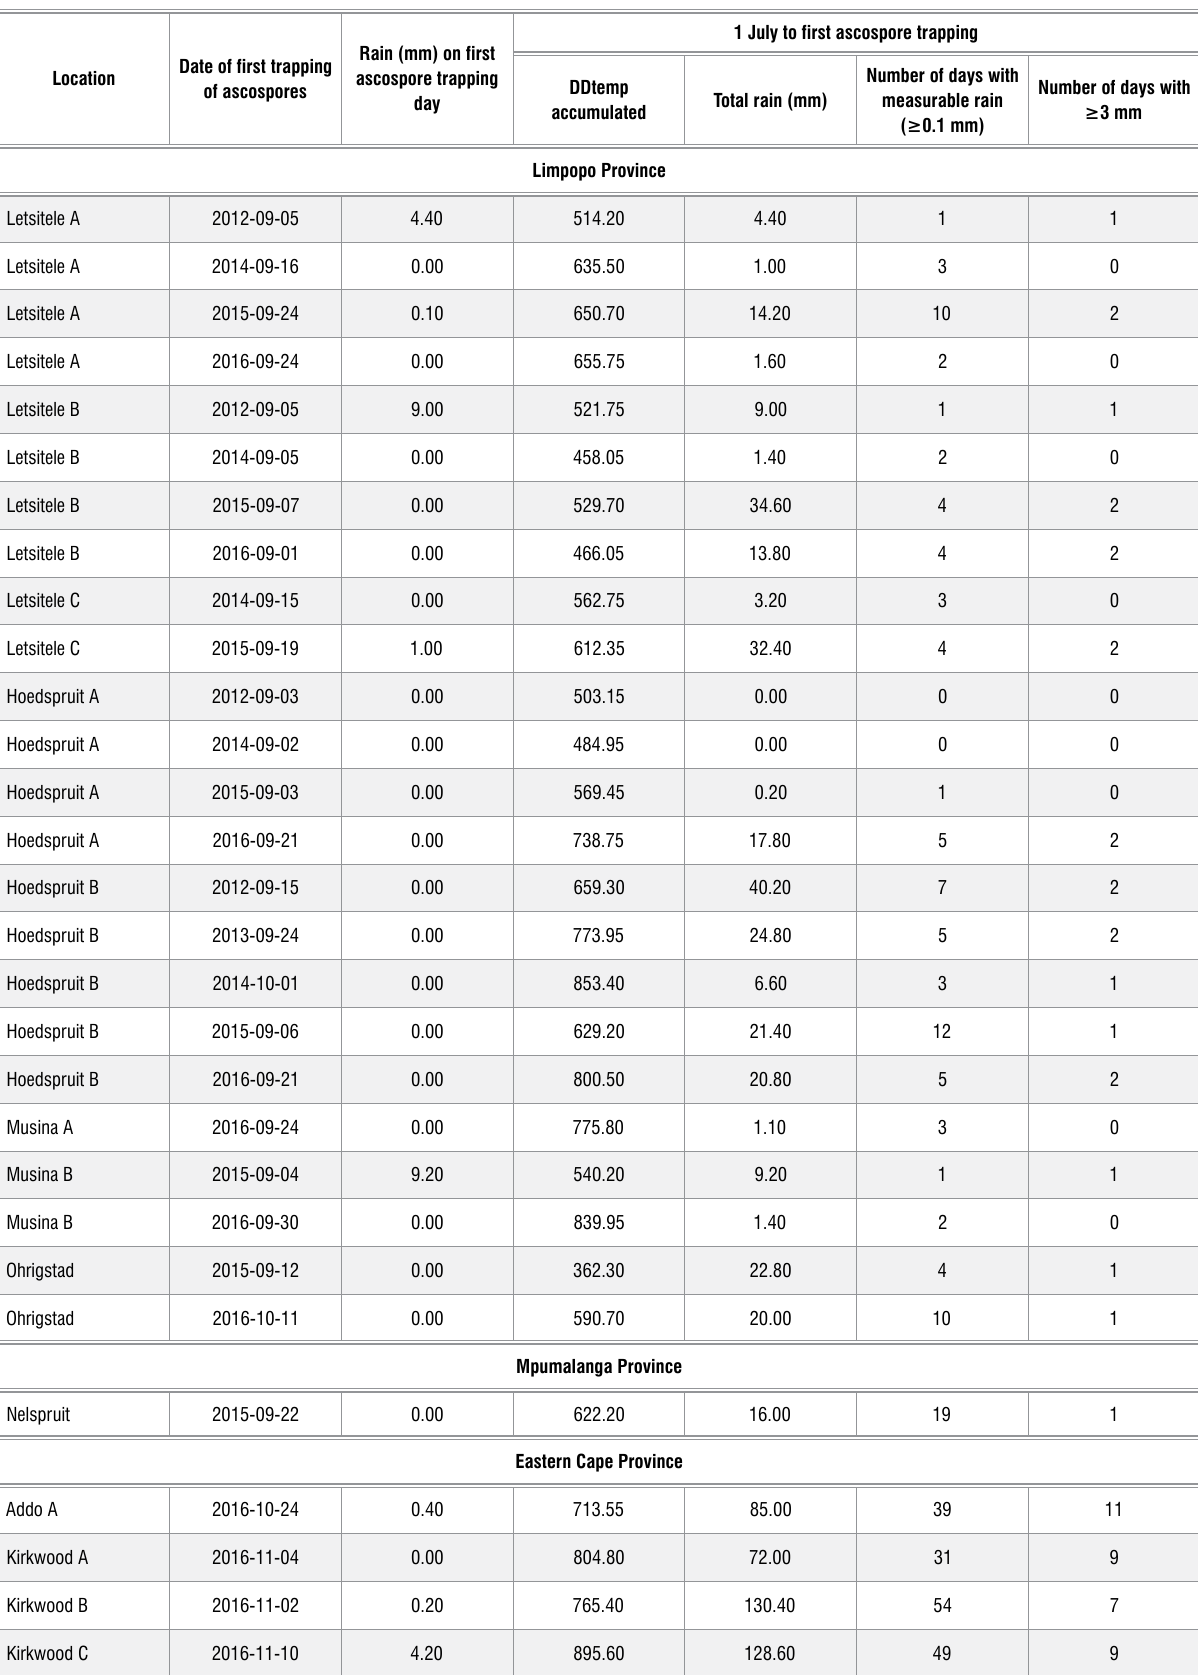
Table 2: Dates of first trapping of Phyllosticta ascospores at 13 locations in South Africa between 2012 and 2016, DDtemp accumulated until first ascospore trapping as well as amount of rain on first day of ascospore trapping and period from 1 July to first trapping